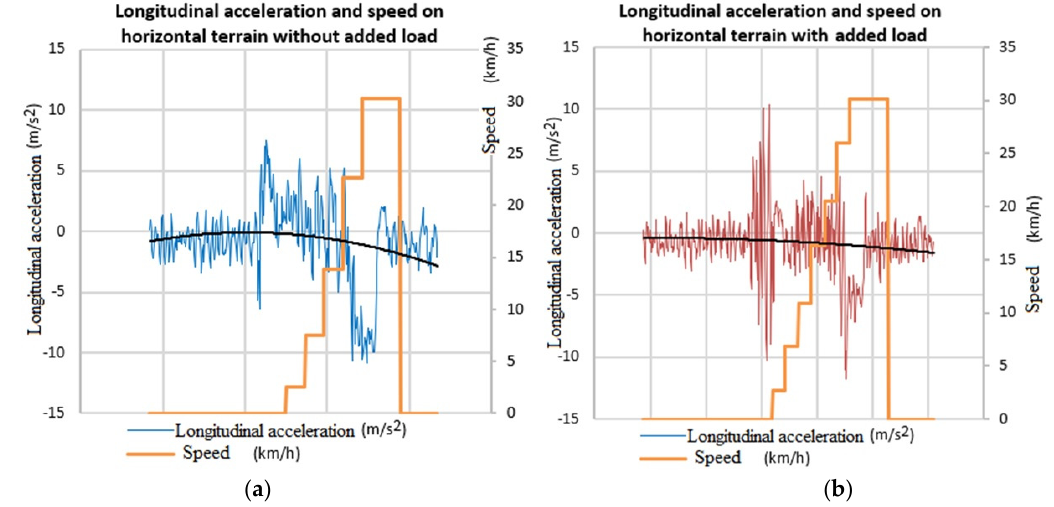
Figure 12. Graphics for longitudinal accelerations and speeds for the ATIRV in practical testing conditions: ( a ) without any attached load on the vehicle; ( b ) with 1000 N load attached on the vehicle. Table 2. Real values gained in practical testing of the experimental ATIRV without added load. Road’s Configuration,